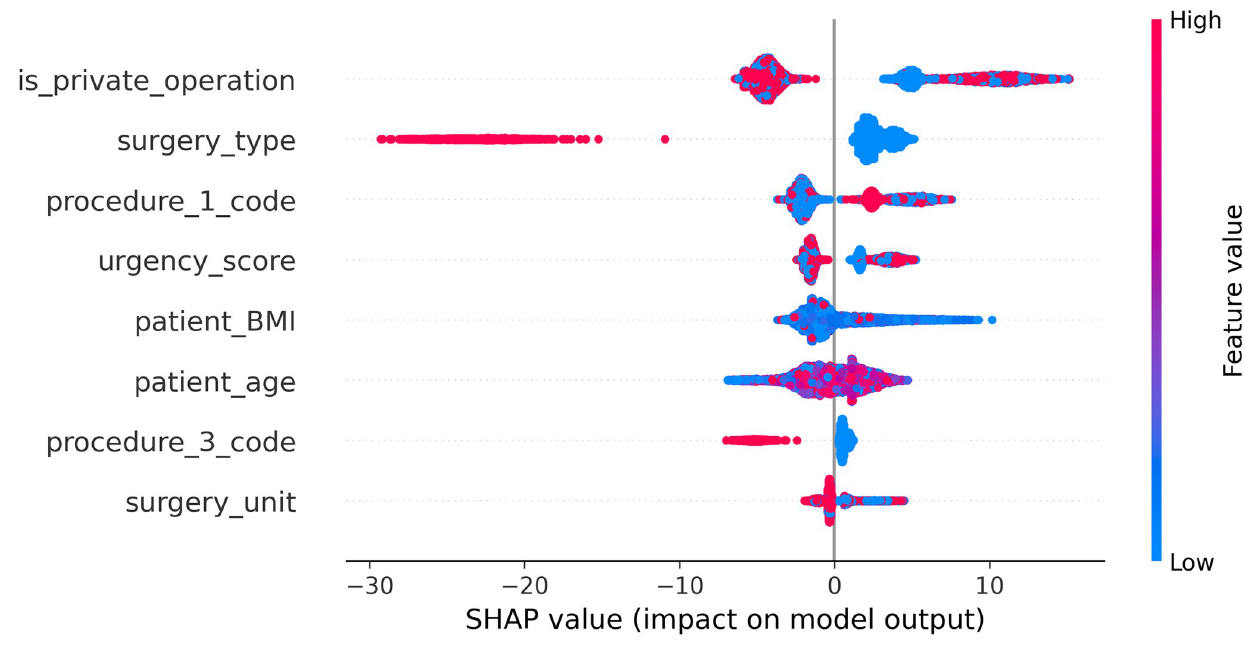
Fig 3. SHAP—DOSM.